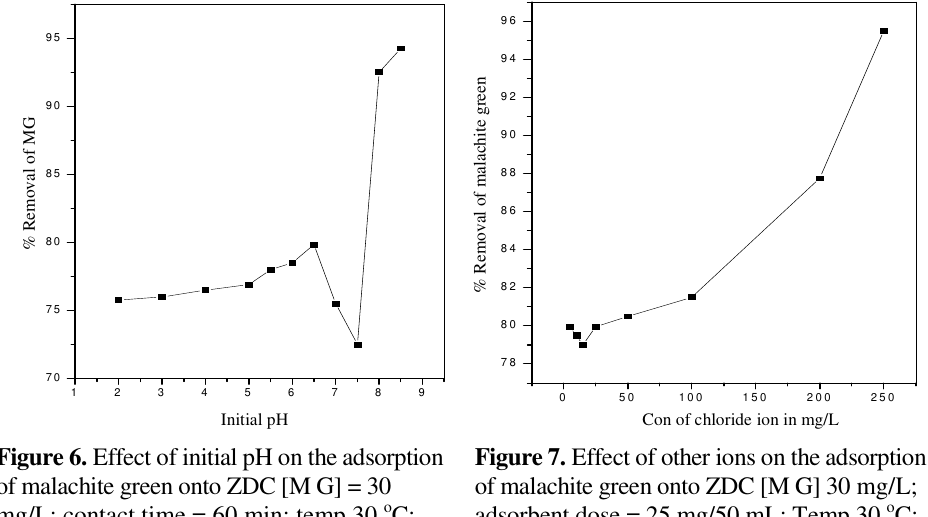
Figure 6. Effect of initial pH on the adsorption of malachite green onto ZDC [M G] = 30 mg/L; contact time = 60 min; temp 30 o C; adsorbent dose = 25 mg/50 mL